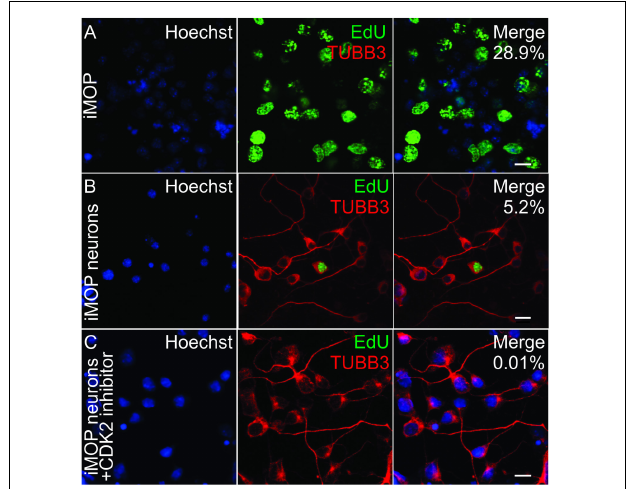
FIGURE 1 | Effects of CDK2 inhibitor in differentiating iMOP cultures. (A) Incorporation of the 5-ethynyl-2 (cid:48) -deoxyuridine (EdU) and TUBB3 immunolabeling in proliferating iMOP cells. EdU and TUBB3 labeling in (B) iMOP-derived neuron cultures, and (C) iMOP-derived neuron cultures treated with 1 µ M K03861. Average percentages of EdU marked cells are represented in merged panels ( n = 3 independent experiments). Scale bars are 10 µ